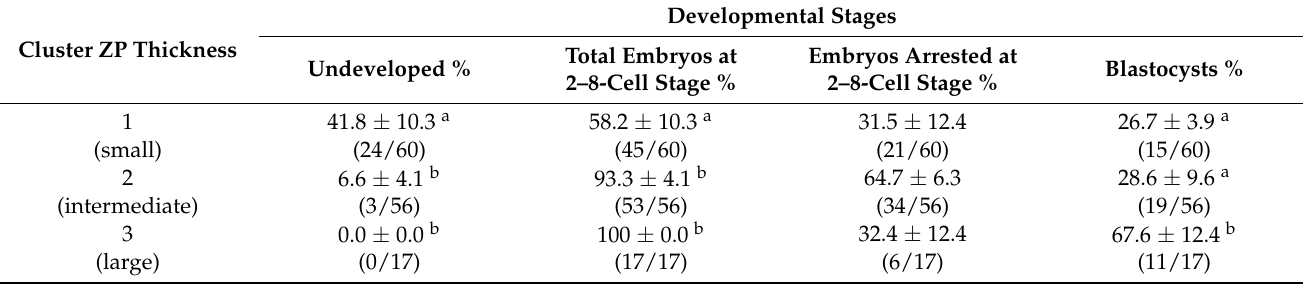
Table 6. Mean values of different developmental stages by clustering of morphometric parameters of oocytes by ZP thickness.